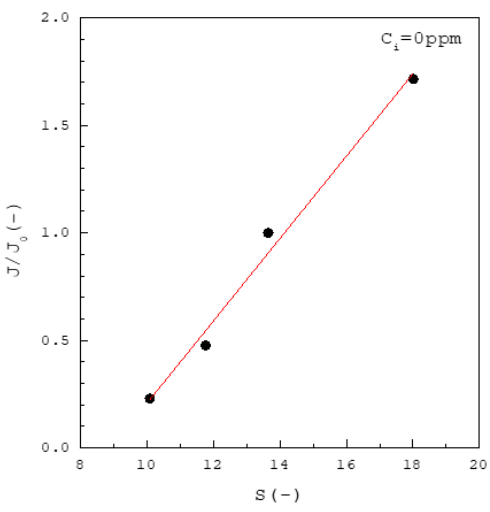
Figure 2. The increase of J with increasing S for calcium oxalate without inhibitors at 37 ◦ C. The solid Figure 2. The increase of (cid:3011) with increasing 𝑆 for calcium oxalate without inhibitors at 37 °C. The J 0 (cid:3011) with increasing 𝑆 for calcium oxalate without inhibitors at 37 °C. The (cid:3011) (cid:3116) line is a visual guide. Figure 2. The increase of (cid:3011) (cid:3116) solid line is a visual guide. solid line is a visual guide.